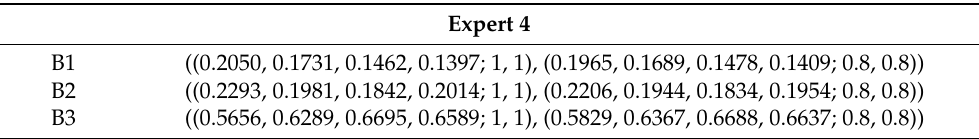
Table 8. Expert 4’s fuzzy weights for the evaluation of secondary indicators under the absorptive capacity